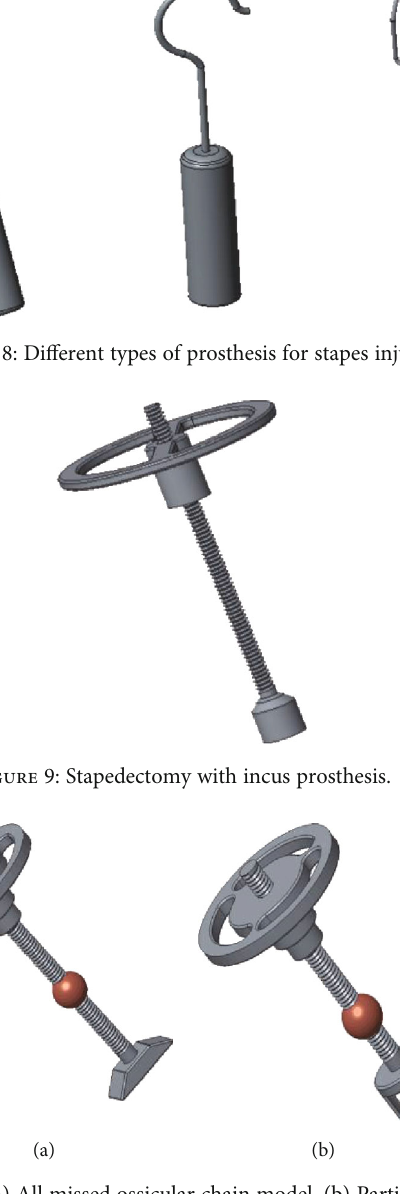
Figure 10: (a) All missed ossicular chain model. (b) Partial missed ossicular chain